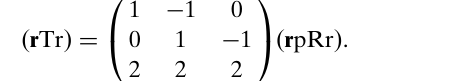
] 2+ cations are 2